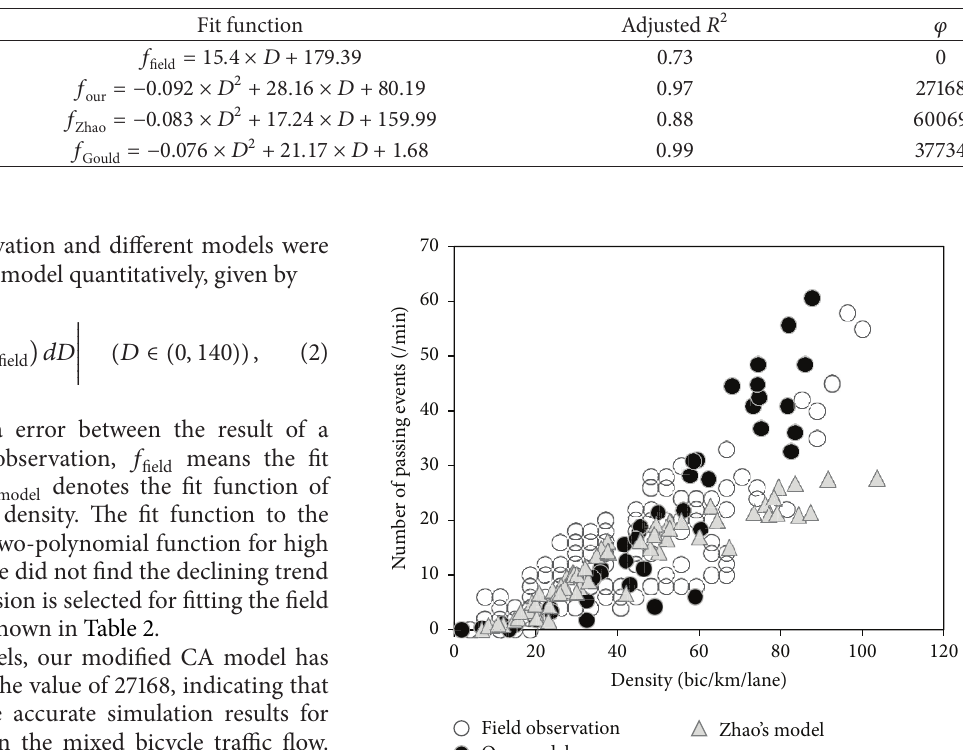
Table 2: Value of 𝜑 to different models.